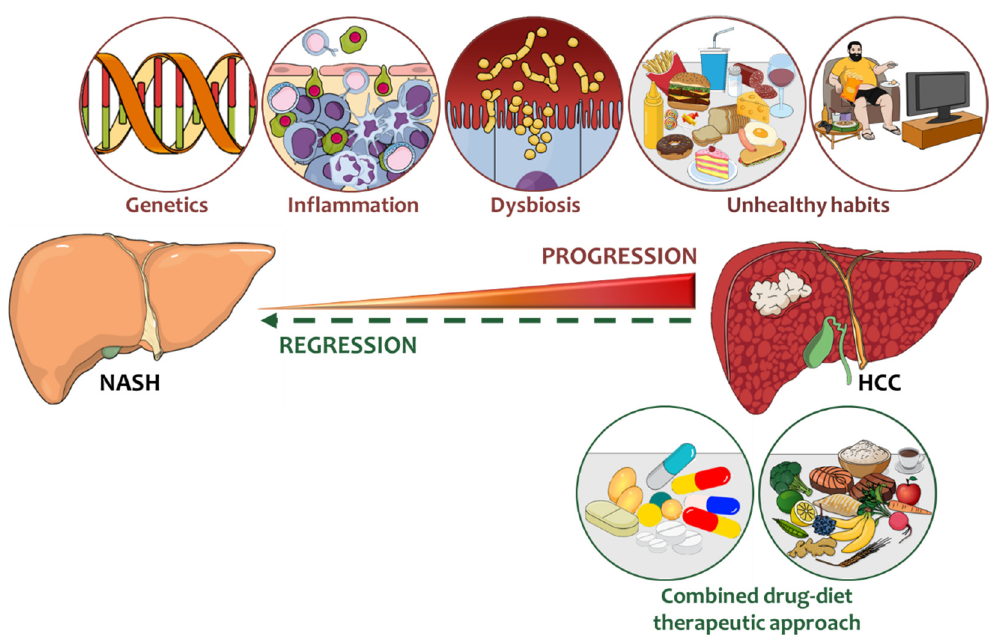
Figure 1. Risk factors that may intervene in the switching from NASH to HCC and current therapeutic approaches. Common and rare genetic variations that influence hepatic lipid handling, immune response and cell proliferation are strongly entangled in the transition towards liver cancer. Likewise, epigenetic phenomena including DNA methylation and histone modifications as well as miRNA perturbations may participate to these deleterious processes. Together with genetics even environmental risk factors such as unhealthy dietary habits, sedentary lifestyle, intestinal high permeability may further exacerbate liver inflammation, ER and oxidative stress, triggering the evolution to HCC. In this regard, nutritional and lifestyle interventions aimed to restore healthy behavior of patients may be helpful to counteract to NASH progression to cirrhosis and HCC. Notably, the combination of current therapeutic strategies (tumor ablation, pan-tyrosine kinase inhibitors, checkpoint blockade and immunotherapy) with dietary advice may maximize benefits, with the pursuit to improve liver function and prolong survival.